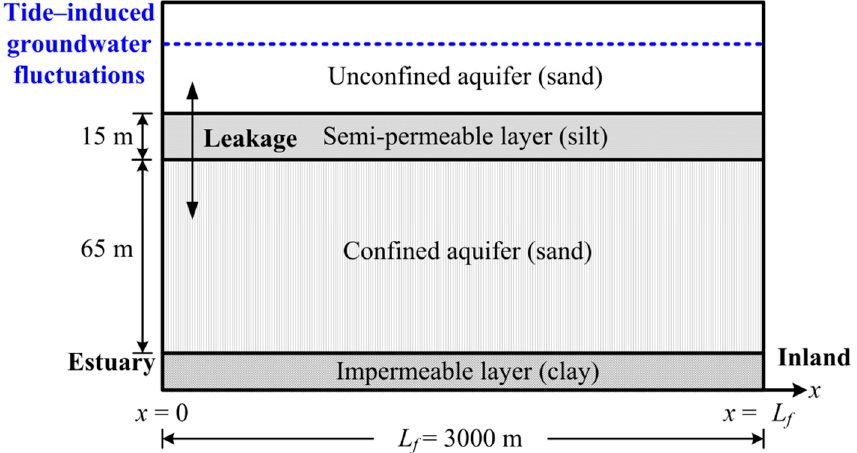
Figure 16. The tidal fluctuation and the measured groundwater response.